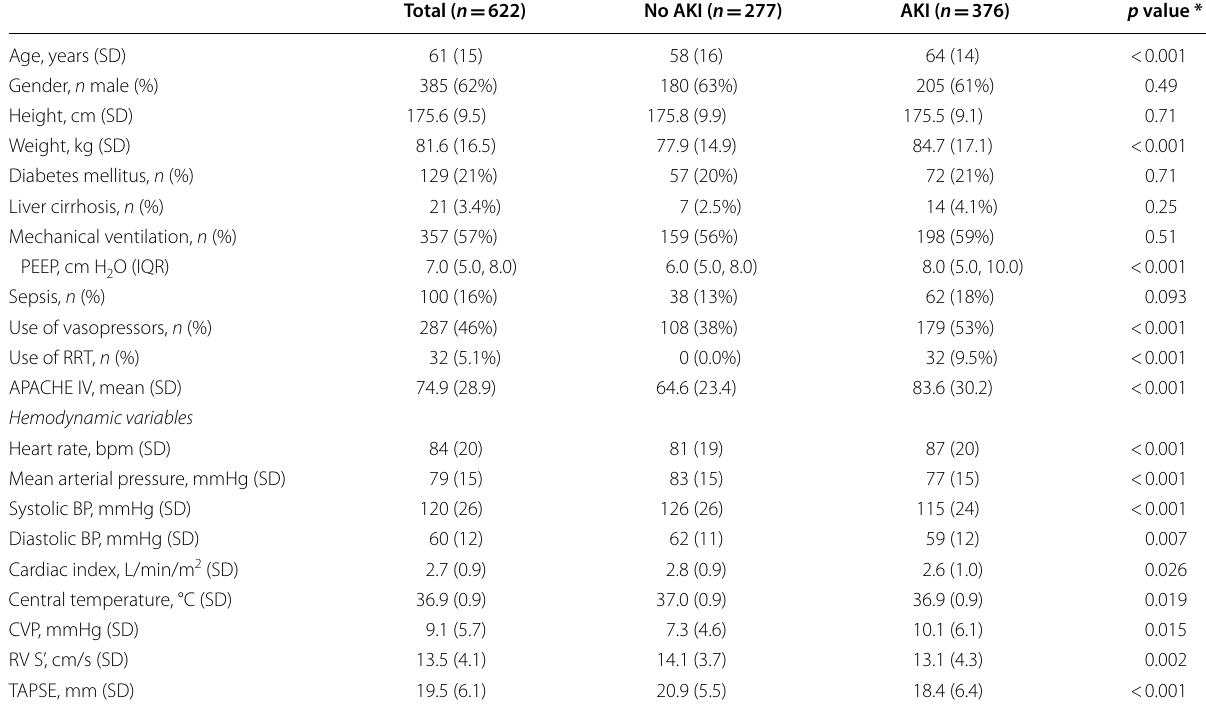
Table 1 Baseline and hemodynamic characteristics in the overall population and patients with and without